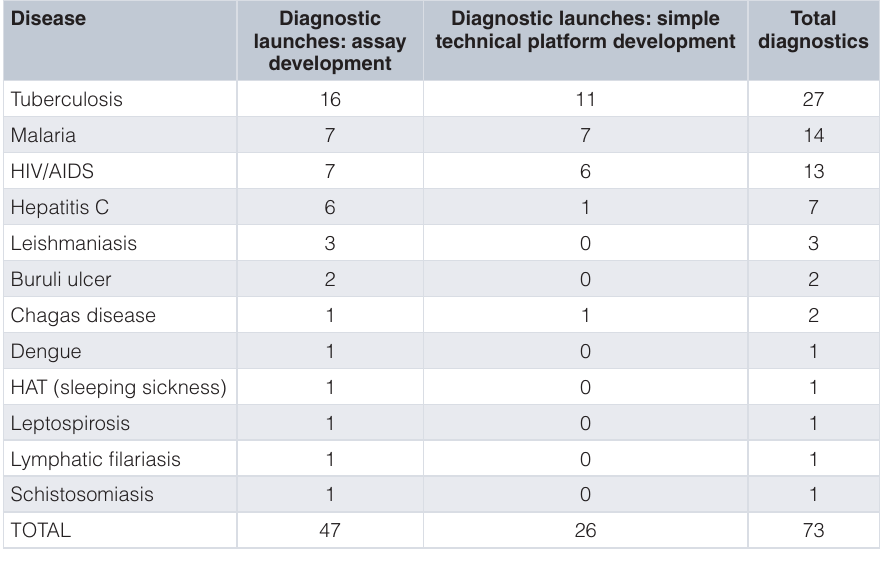
Table 8. Breakdown of anticipated diagnostics launches by archetype (assay development versus simple technical platform development) and disease parameters, percentage change from baseline, estimated cost ($, millions), estimated number of product launches.